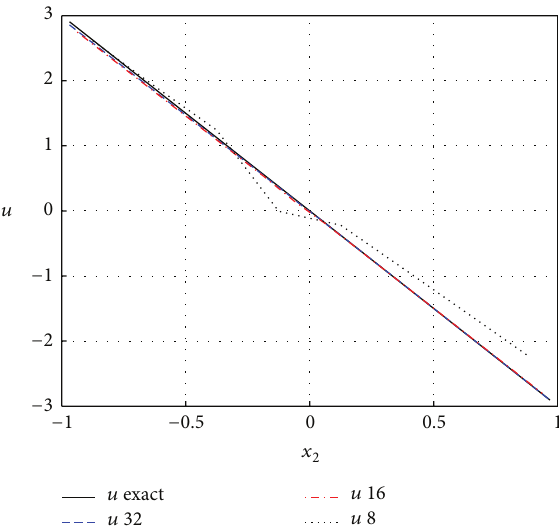
Figure 1: Optimal feedback control for Example 1 via the SHWCM with 𝑚 = 8, 16 and 𝑥 1 = −0.1250, −0.0625 , respectively.